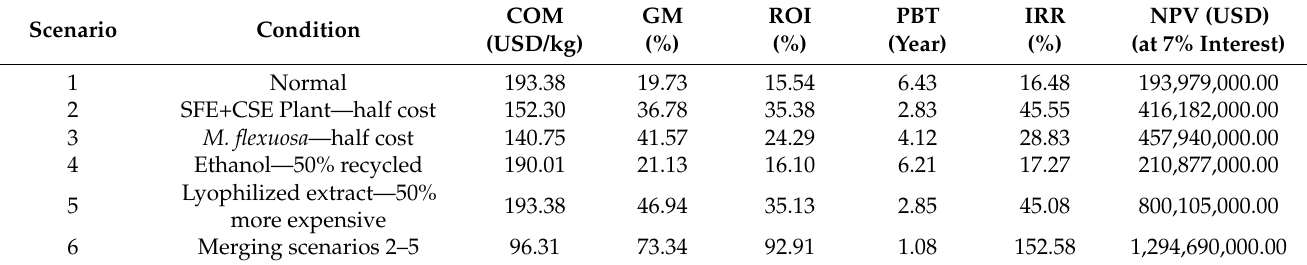
Table 2. Project indices of the sequential two-stage process